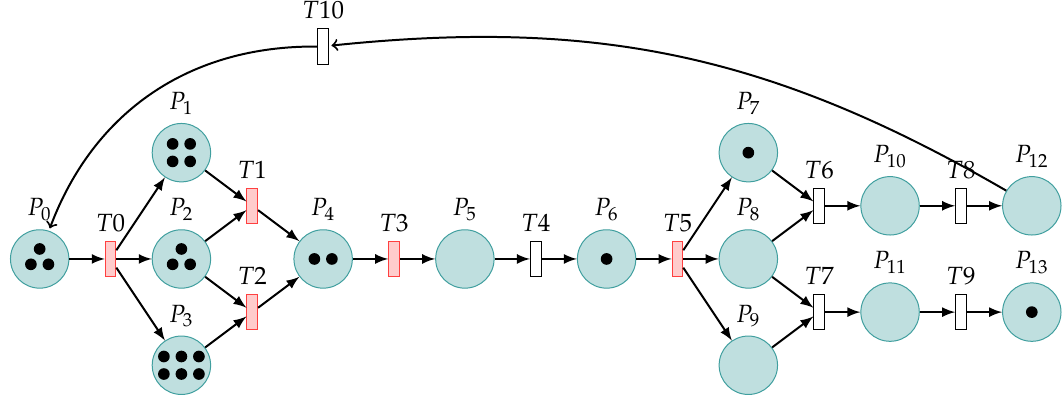
Figure 5. The model reaches an unsafe state for the first